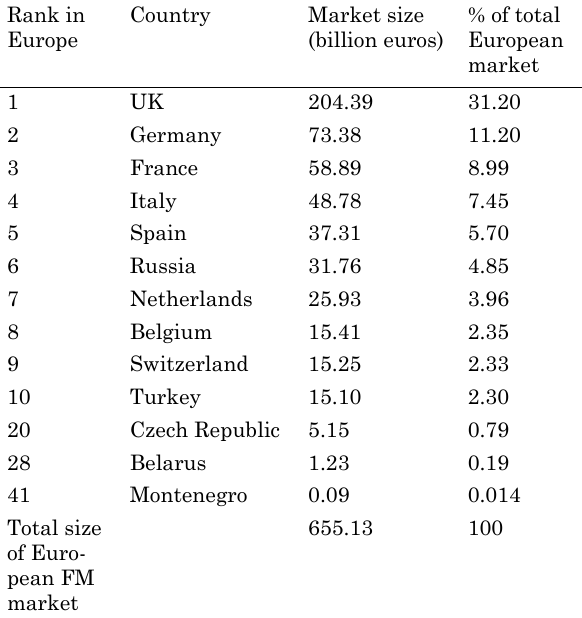
Table 2. FM market size in